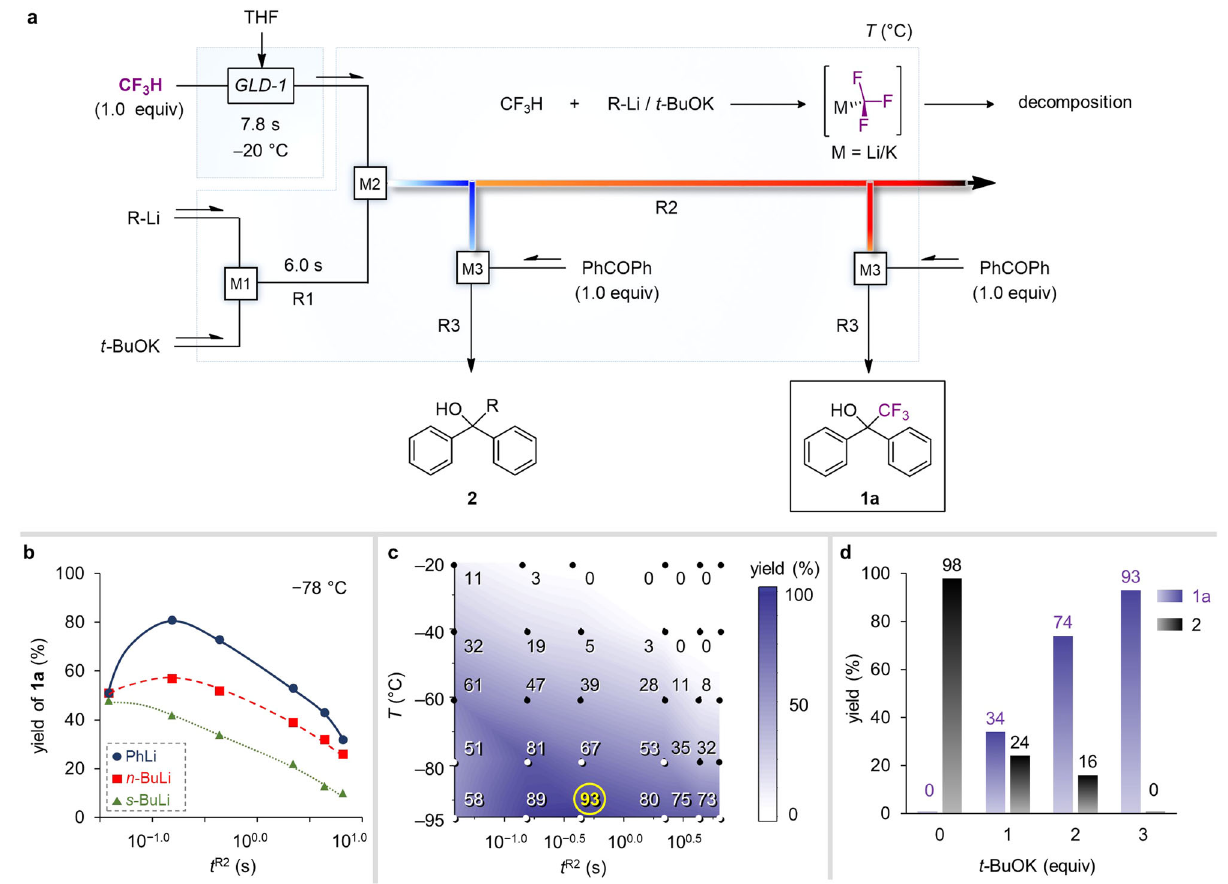
Fig. 3 | Optimization of reaction condition for ex situ generation of CF 3 − from CF 3 H in fl ow. a A schematic diagram of the fl ow system. b An effect of the type of organolithium on the yield of product 1a . c Effects of temperature and residence